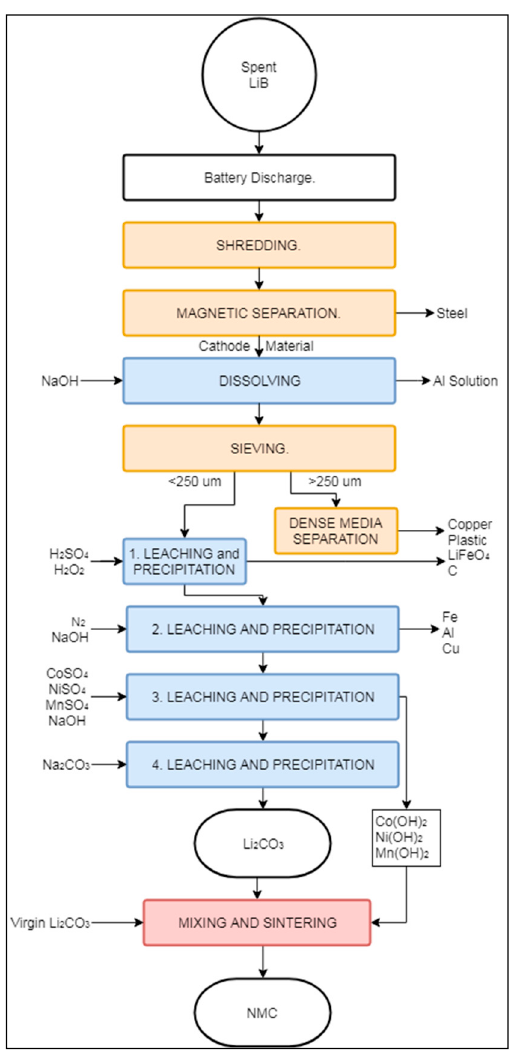
Figure 8. Schematic representation of the Battery Resources recycling process.